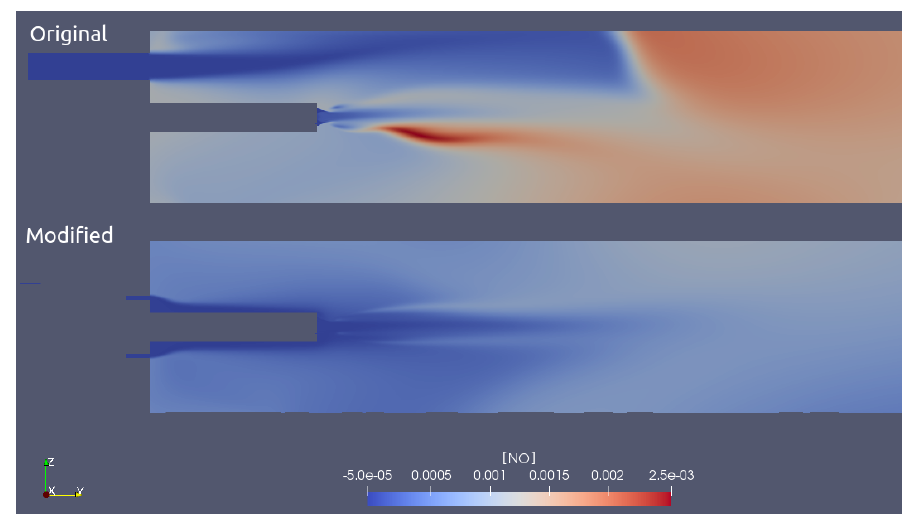
Figure 9. Contour plot of the computed NOx mass fraction (dimensionless) near the burner on the central axial slice for the original rectangular ( top ) and modified ( bottom ) secondary air